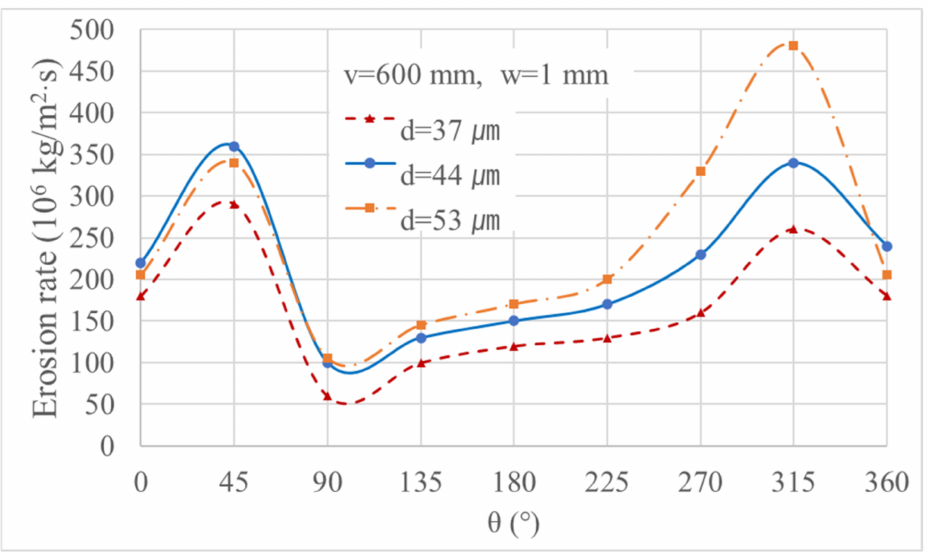
Figure 9. Erosion rate density against different values of slurry